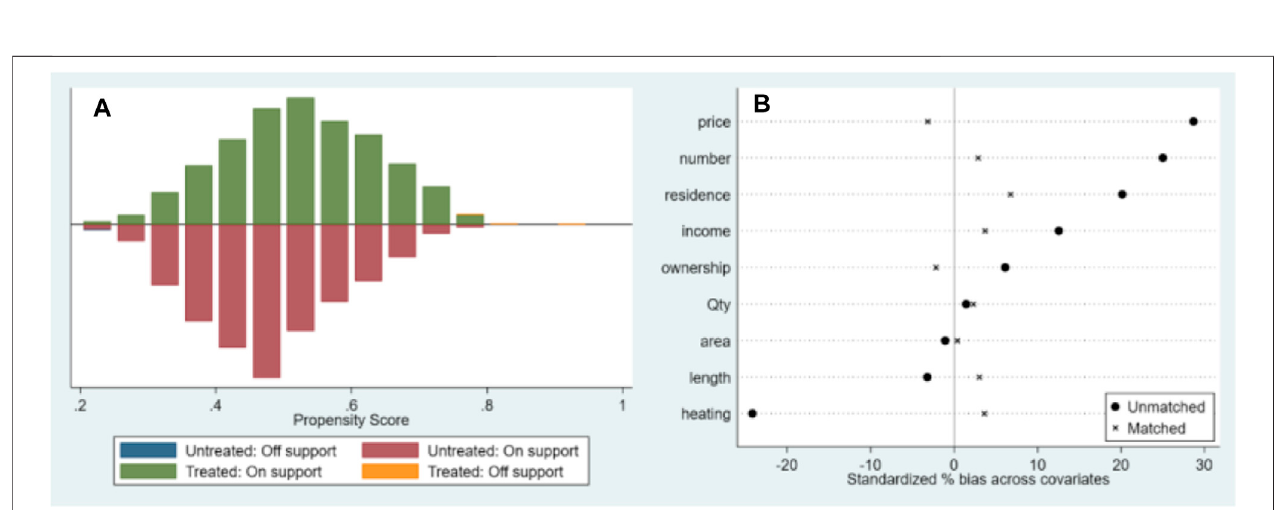
FIGURE 3 | Matching quality and balancing tests of smart meters. (A) Distribution of propensity score; (B) Standard bias across covariates after matching.